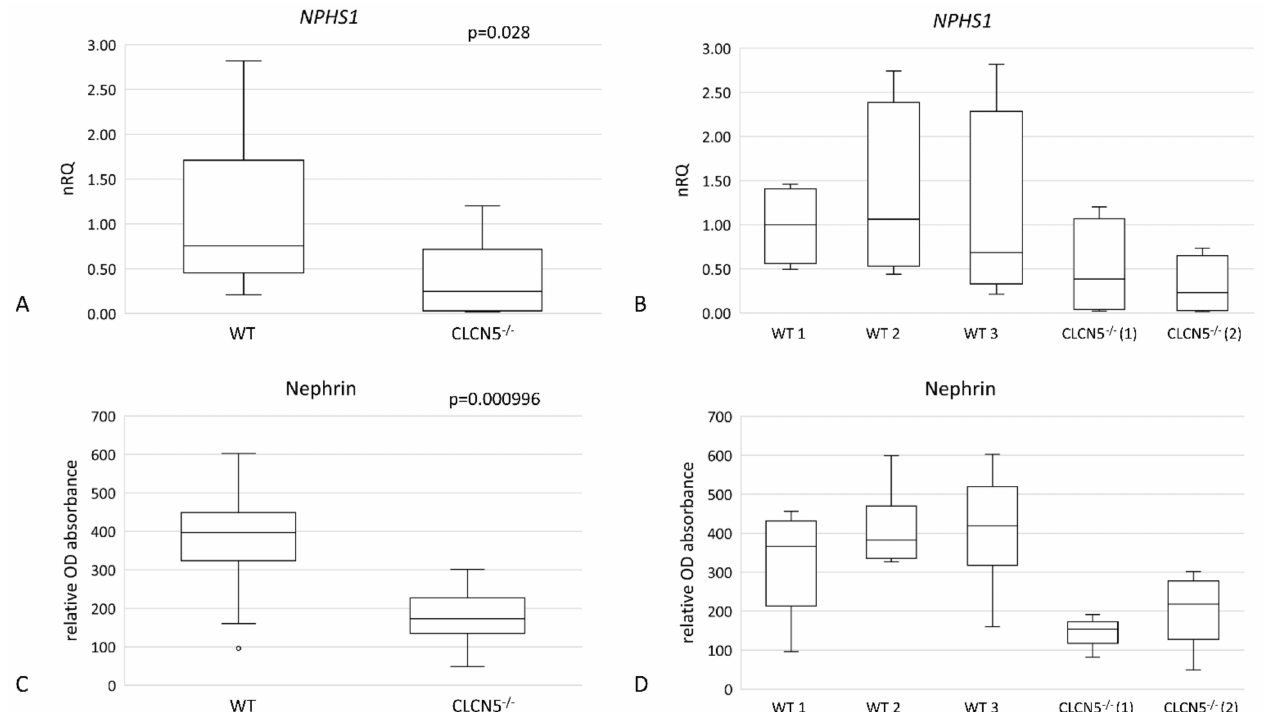
Figure 5. Nephrin gene ( NHPS1 ) and protein expression in WT and CLCN5 − / − clones. Boxplots show ( A , B ) relative mRNA, as determined by qRT-PCR, and ( C , D ) protein expression, as determined by ICW. p -values were obtained with the Mann-Whitney U test. Results are from two indepen- dent experiments performed in triplicate. Abbreviations: nRQ: normalized relative quantity; OD, optical